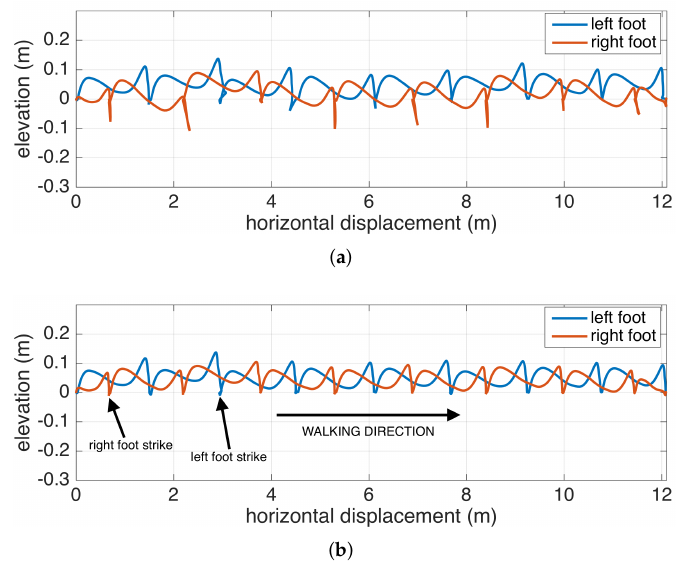
Figure 6. Lateral view of a walking subject: ( a ) only Kalman filtering, ( b ) Kalman filtering with Rauch–Tung–Striebel (RTS)